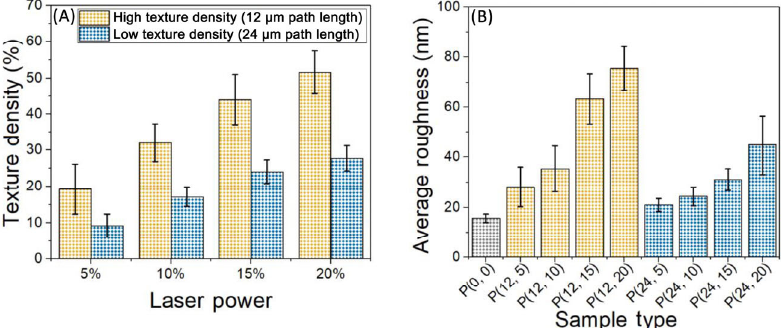
Fig. 3 Texture density and average surface roughness of surfaces with two different texture path segment length of 24 and 12 μ m and four different laser powers: (A) texture density and (B) average surface roughness of smooth and laser textured stainless steel